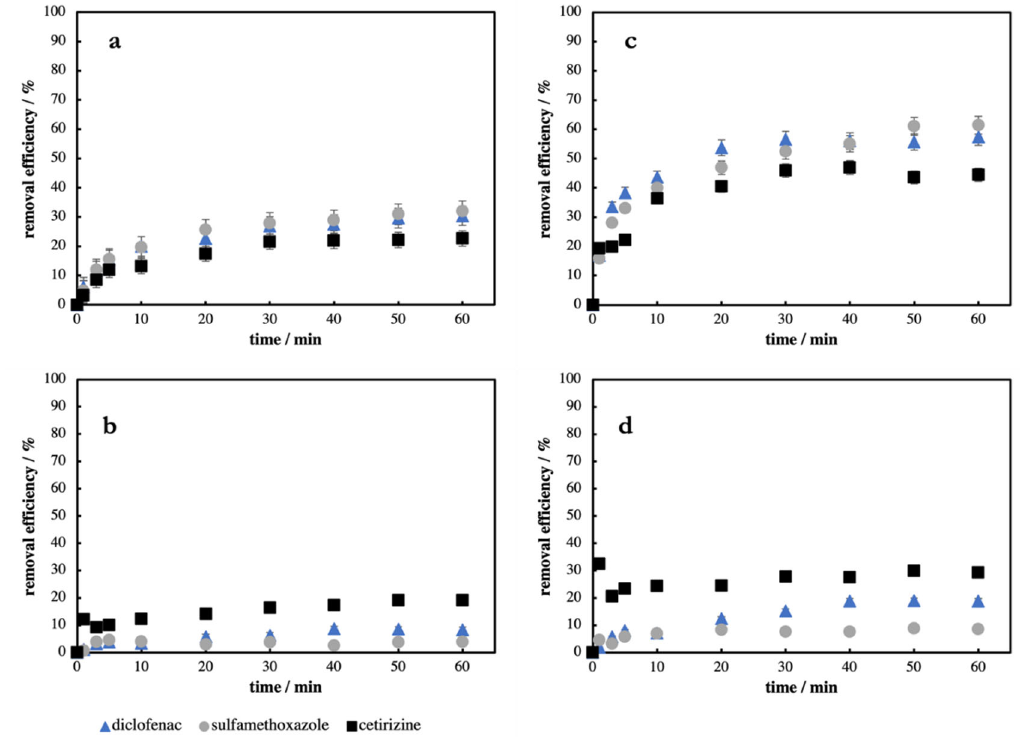
Figure 3. Dependence of removal efficiency of diclofenac, sulfamethoxazole and cetirizine mixture from time using 10 mg/L of ( a ) WSCl2 and ( b ) HWOH; ( c ) 30 mg/L of WSCl2 and ( d ) HWOH as adsorbent.